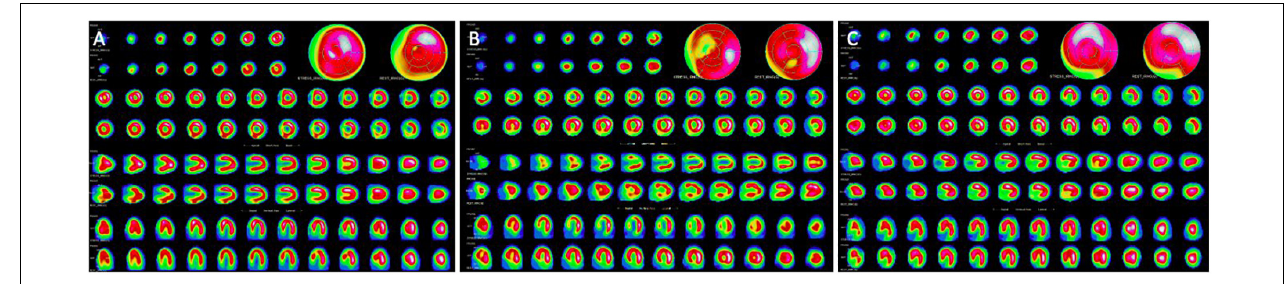
FIGURE 2 | Stress and rest myocardial perfusion SPECT. (A) Normal stress and rest myocardial perfusion SPECT. (B) Stress-induced antero-septal and antero-apical ischemia in the setting of left anterior descending artery critical stenosis. (C) Fixed inferior perfusion defect on both rest and stress acquisitions: this pattern can be related to scarring form infarction or hibernating